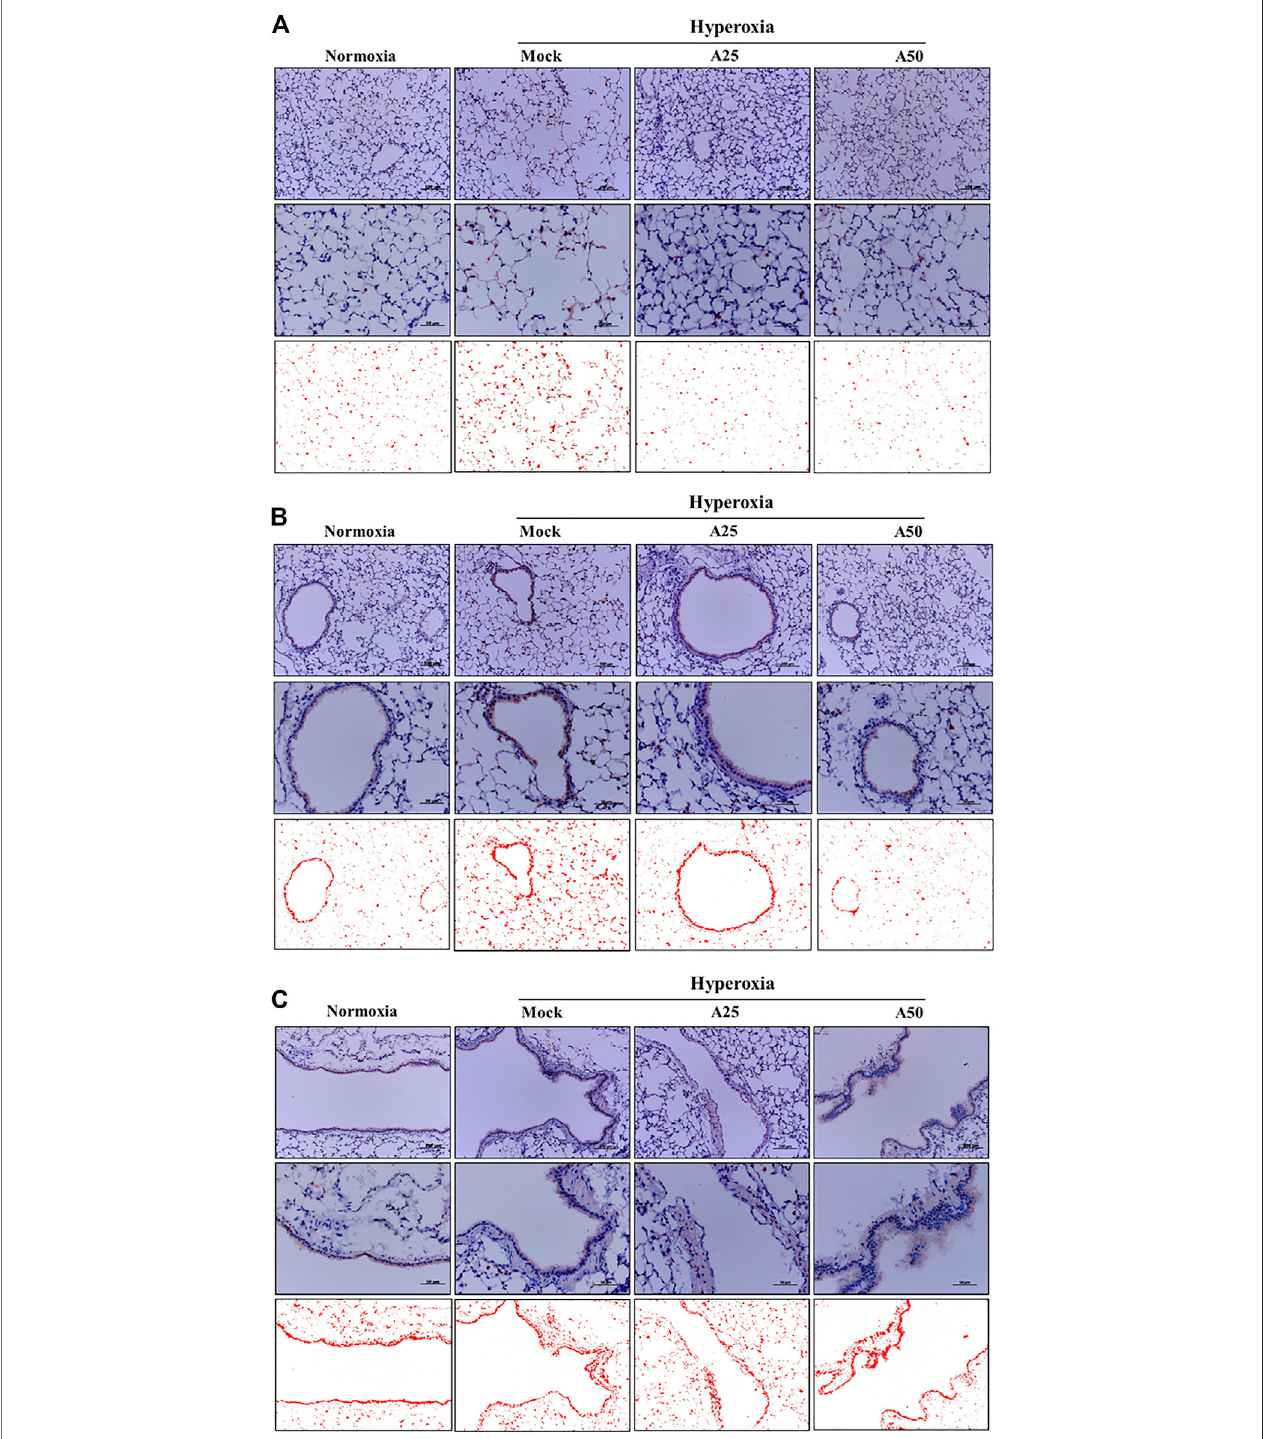
FIGURE 6 | Therapeutic ef fi cacy of aspirin in altering levels of the CXCL4 protein induced by hyperoxia in NF- κ B-luciferase +/+ transgenic mice, as detected using immunohistochemical (IHC) staining (A) Images of alveoli; scale bars for the upper panel represent 200 µm and middle panel represent 50 µm (B) Images of bronchi; scale bars for the upper panel represent 200 µm and middle panel represent 50 µm (C) Images of blood vessels. Scale bars for the upper panel represent 200 µm and middle panel represent 50 µm. DAB-speci fi c threshold selection (red selection) was performed using ImageJ software. NF- κ B-luciferase +/+ transgenic mice were assignedtofourgroups( n (cid:1) 6micepergroup):Mockgroup,treatmentwithPBSat0,24and48 h,andexposuretohyperoxiafor72 h.A25group,treatmentwith25 μ g/ g aspirin at 0, 24 and 48 h, and exposure to hyperoxia for 72 h. A50 group: treatment with 50 μ g/g aspirin at 0, 24 and 48 h, and exposure to hyperoxia for 72 h.